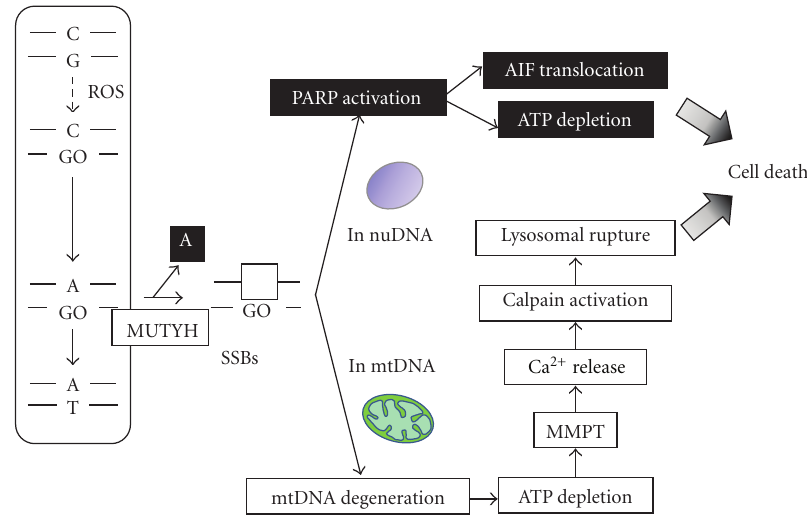
Figure 1: Scheme of apoptotic death signaling by accumulation of 8-oxoguanine (8-oxoG; GO) and single-strand-breaks (SSBs) in DNA. ROS, especially hydroxyl radical, increase the 8-oxoG accumulation and SSBs by MUTYH. In the case of SSBs in nucleus, activation of poly (ADP-ribose) polymerase (PARP), apoptosis inducing factor (AIF) translocation from mitochondria to nucleus, and ATP depletion followed by NAD + depletion leads to cellular apoptosis. On the other hands, in mitochondria, accumulation of SSBs induces mitochondrial DNA (mtDNA) degeneration. Loss of function of energy supply leads to ATP depletion, and mitochondrial membrane permeability transition (MMPT), and calpain activation results in lysosomal rupture, which potentiates cell death (modified from Figure 8, Oka et al., 2008 [49]).